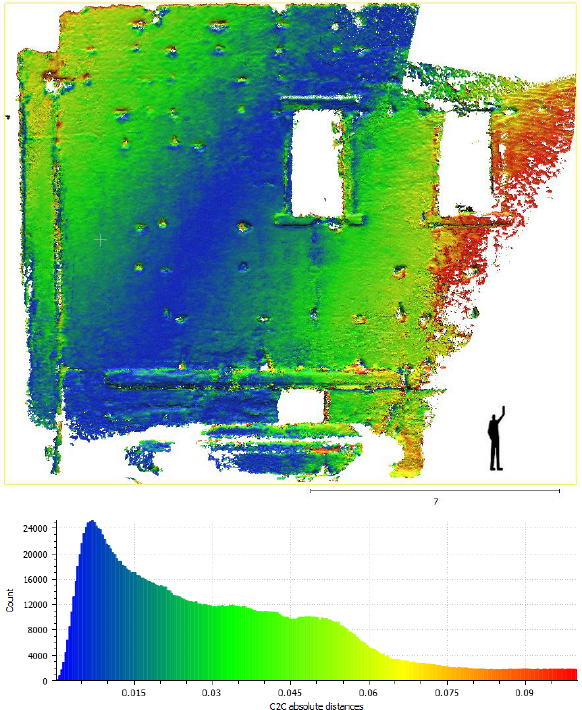
Figure 8: Evaluation of the distances a between common portion of the two clouds after the co-registration using panoramas centres as virtual control points.